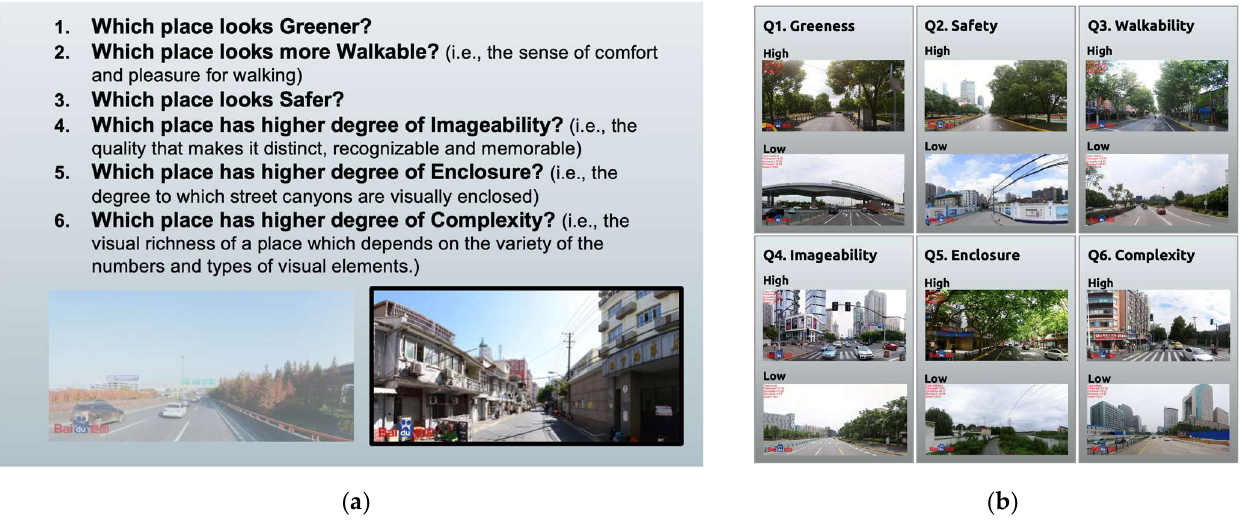
Figure 4. An online survey platform to collect subjective streetscape perceptions. ( a ) The website invited participants to choose one of pairwise images in response to the six evaluative questions. ( b ) Examples with a high and a low score for the six subjective perception qualities.